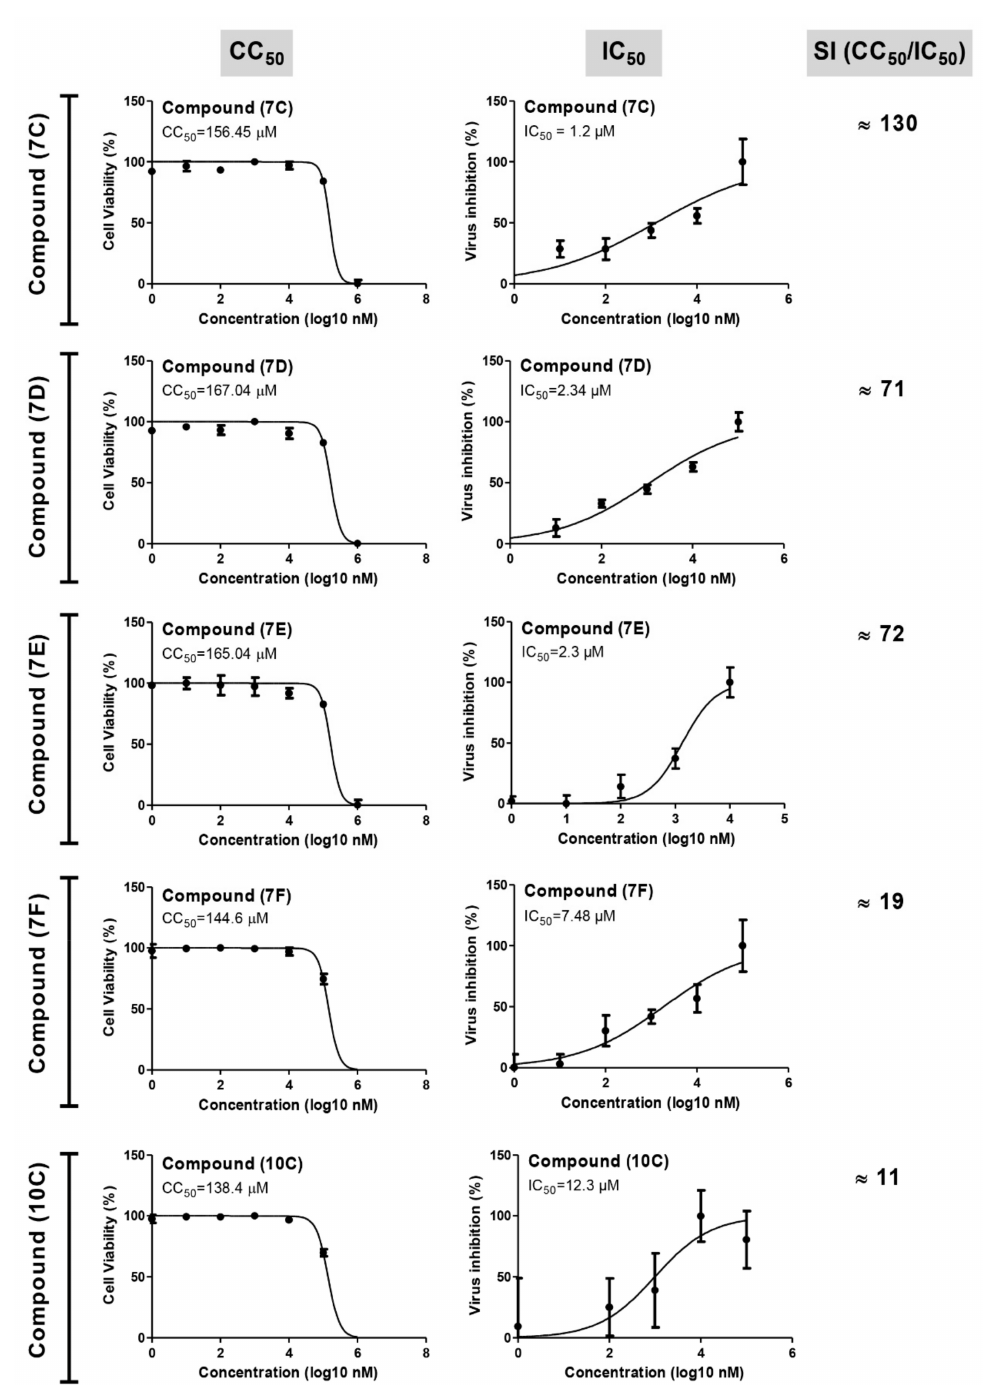
Figure 3. Cell viability and virus inhibition assays for the novel tested anti-viral drugs in Vero-E6 cells. Various dilutions of the drugs were applied to the 90% confluent cell monolayers and assayed after 72 h with MTT